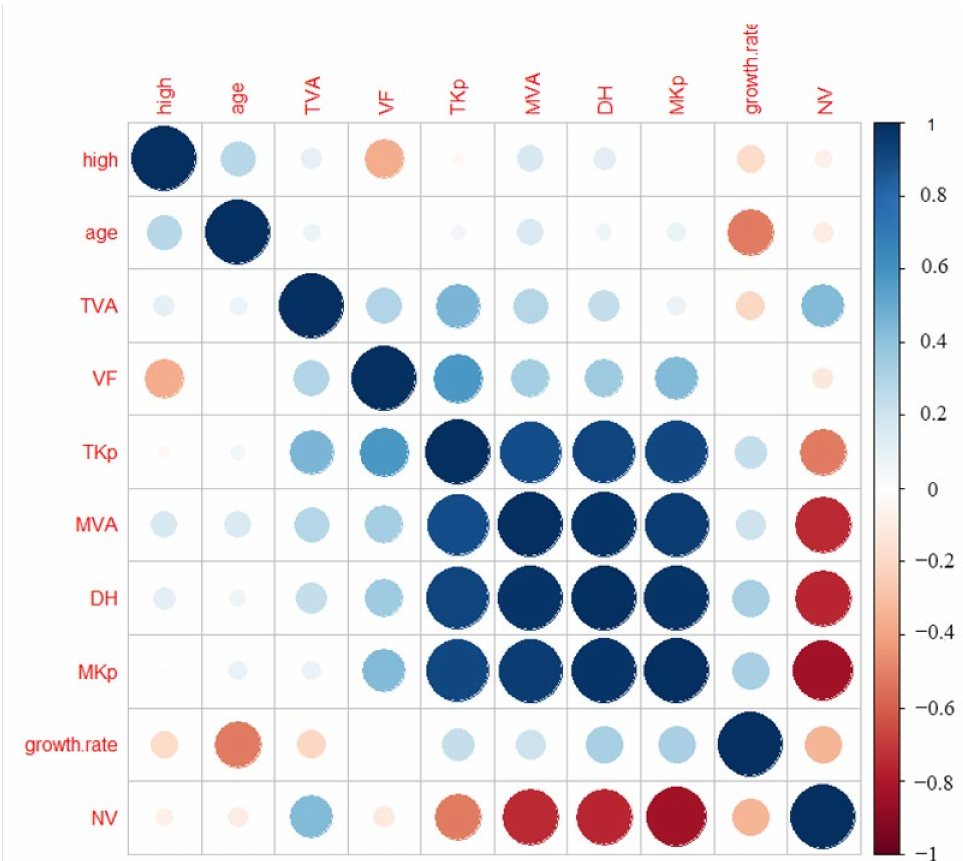
Figure 5. Relationship between the anatomical parameters of the roots of the Zygophyllaceae plants in arid and semi-arid areas of China. High: plant age height (m); Age: (year); Growth.rate: ( µ m/year); NV: vessel number; VF: vessel fraction (%); TAV: total vessel area ( µ m 2 ); MVA: mean vessel